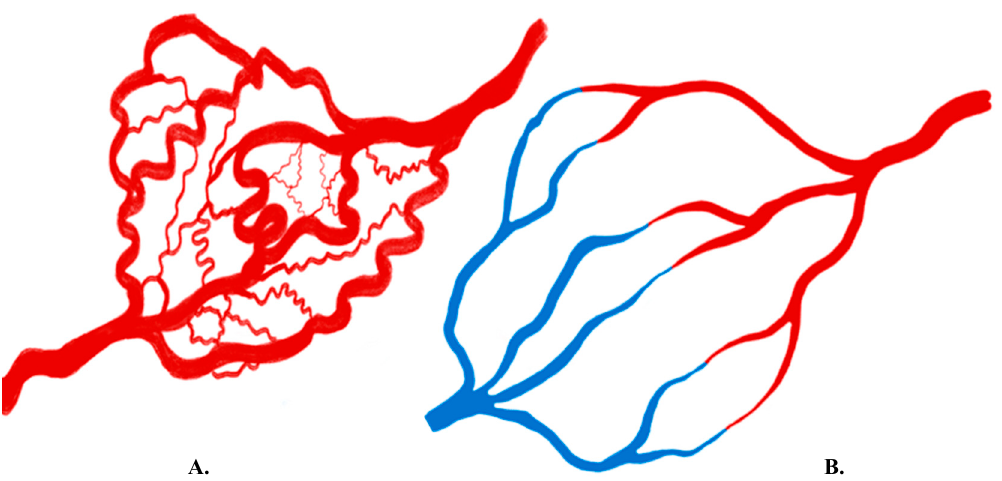
A. B. Figure 2. ( A ) Schematic representation of tumor vasculature showing disorganized architecture of the neo-angiogenesis with arteriovenous shunting. ( B ) Schematic representation of normal vasculature showing well organized arteriovenous capillary formation, red represents oxygenated blood and blue represents deoxygenated blood. (adapted from: Imaging Angiogenesis: Applications and Potential for Drug Development. Janet C. Miller, et al. Journal of the National Cancer Institute, 2005